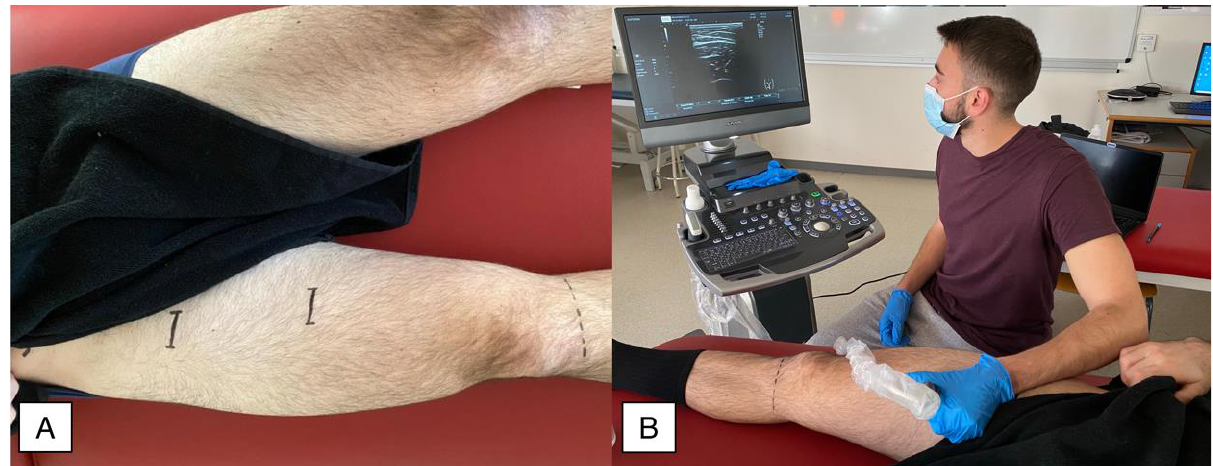
Figure 1. ( A ) Location of the examination point and ( B ) Probe placement during the assessment.